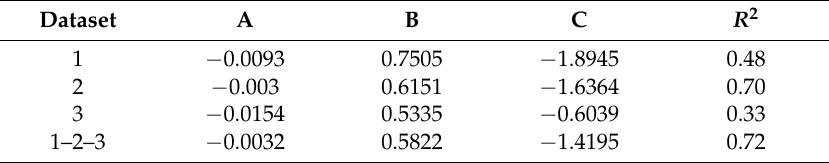
Table 7. Estimation of pruning height using different regression models.